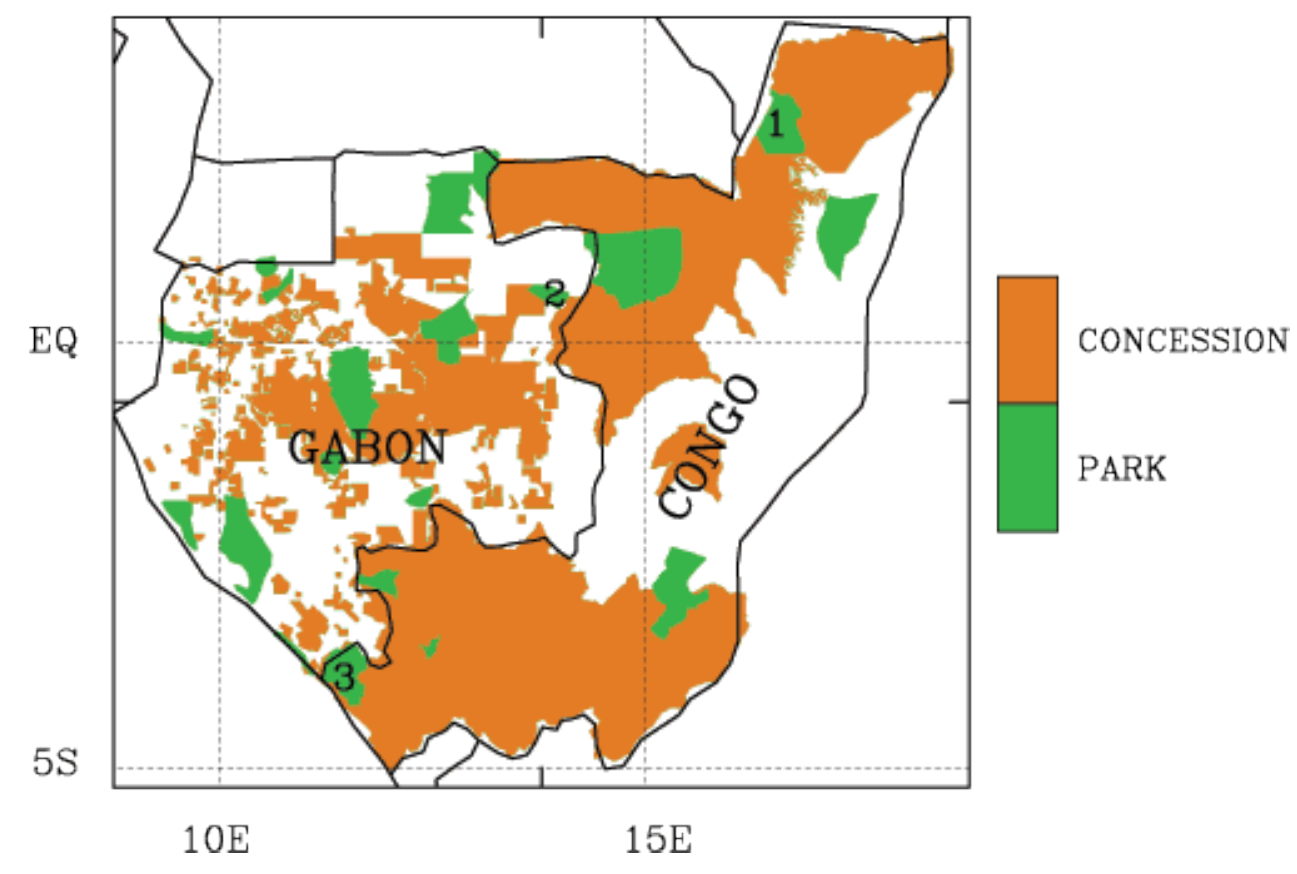
Fig. 2 . Map of the logging concessions and protected areas in Gabon and the Republic of Congo